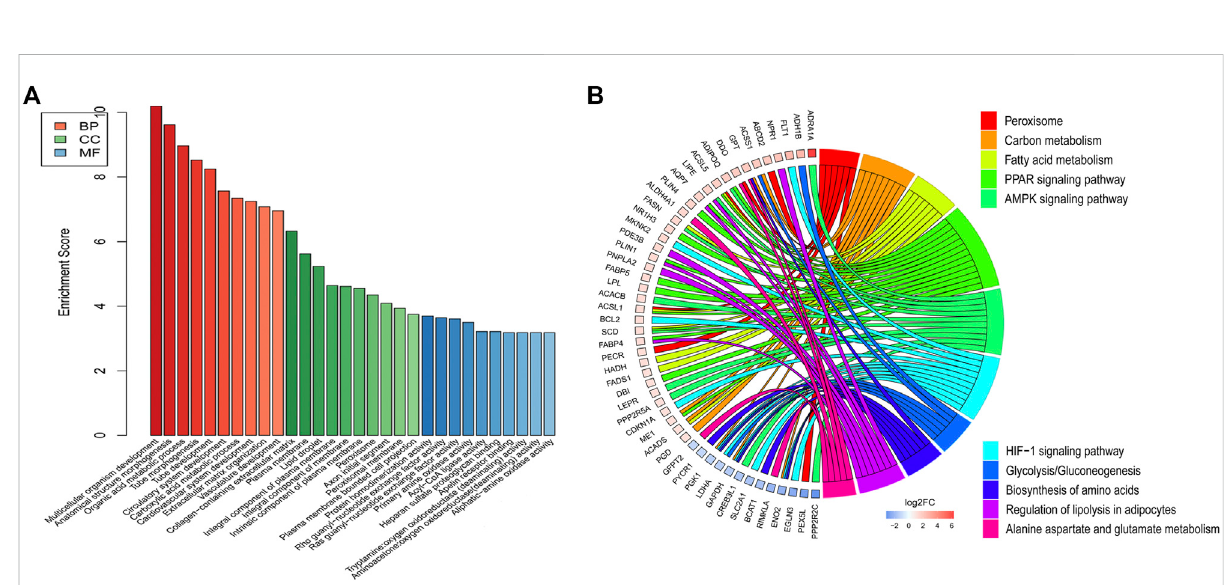
FIGURE 4 GO and KEGG pathway analysis. (A) Top 10 GO terms with the largest signi fi cant difference in the three domains. (B) Top 10 KEGG signaling pathways with the largest signi fi cant